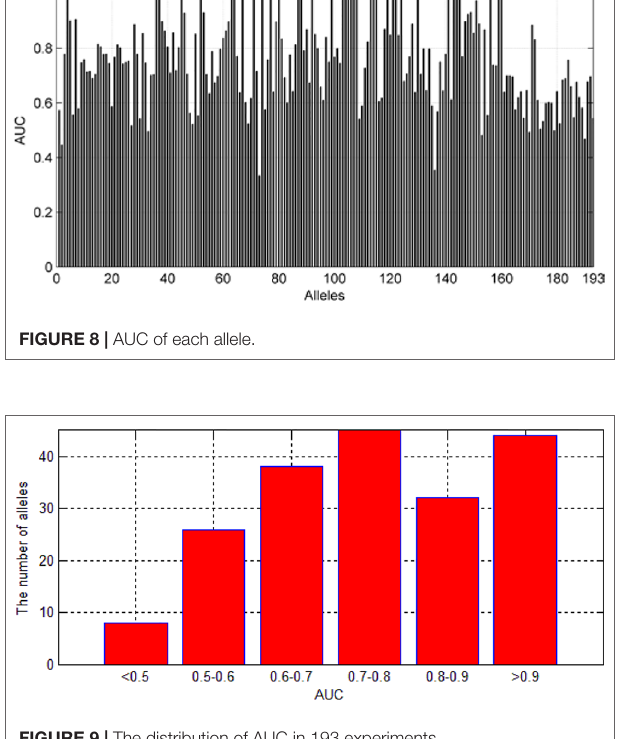
FIgURe 9 | The distribution of AUC in 193